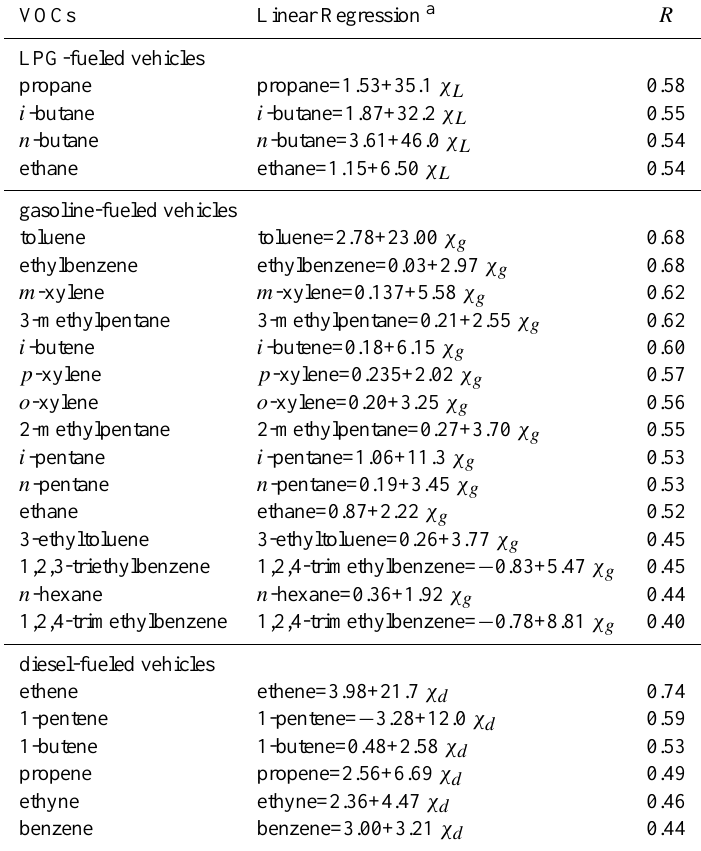
Table 3. Correlation of emission factors of selected VOCs with the change of the fractions of vehicle types. VOCs Linear Regression a R LPG-fueled vehicles propane propane=1.53+35.1 χ L 0.58 i -butane i -butane=1.87+32.2 χ L n -butane n -butane=3.61+46.0 χ L ethane ethane=1.15+6.50 χ L 0.54 gasoline-fueled vehicles toluene toluene=2.78+23.00 χ